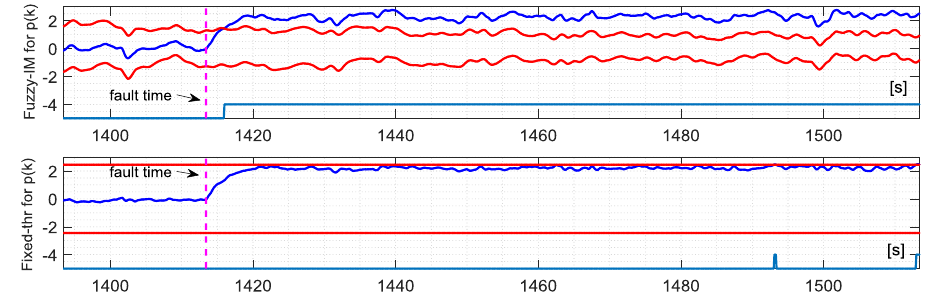
Figure 7. Evolution of the NR residual for the p ( k ) sensor and the corresponding FD intervals as long as the binary fault indicator for the FIM approach ( Upper ) and fixed-thresholds approach ( Lower ) in case of validation flight number 1.